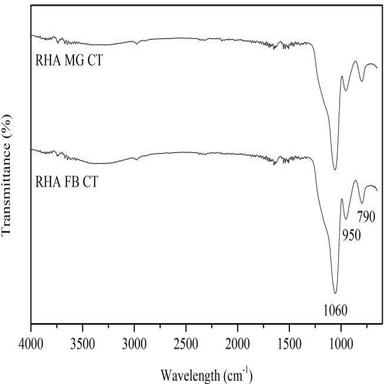
FTIR spectrum of amorphous silicas extracted from RHA FB and RHA MG.